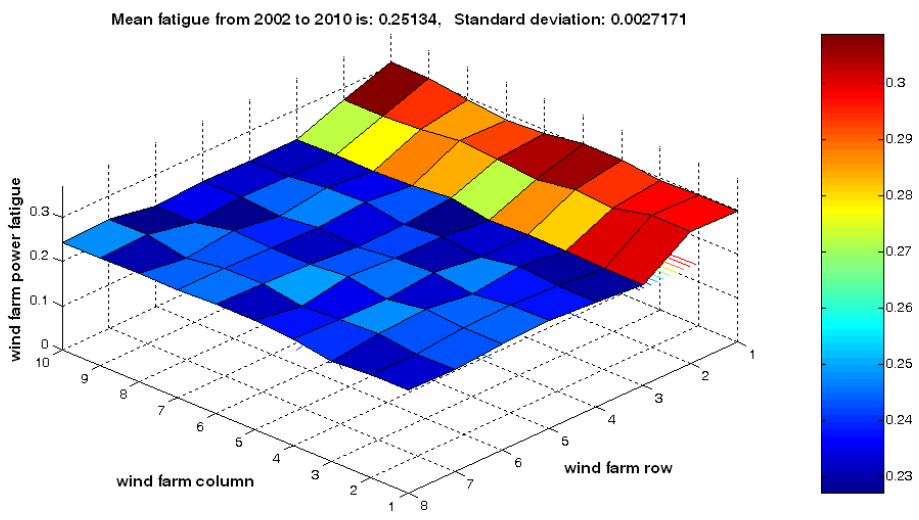
Figure 8. Conventional farm fatigue distribution (2002–2010, Horns Rev OWF, Denmark).